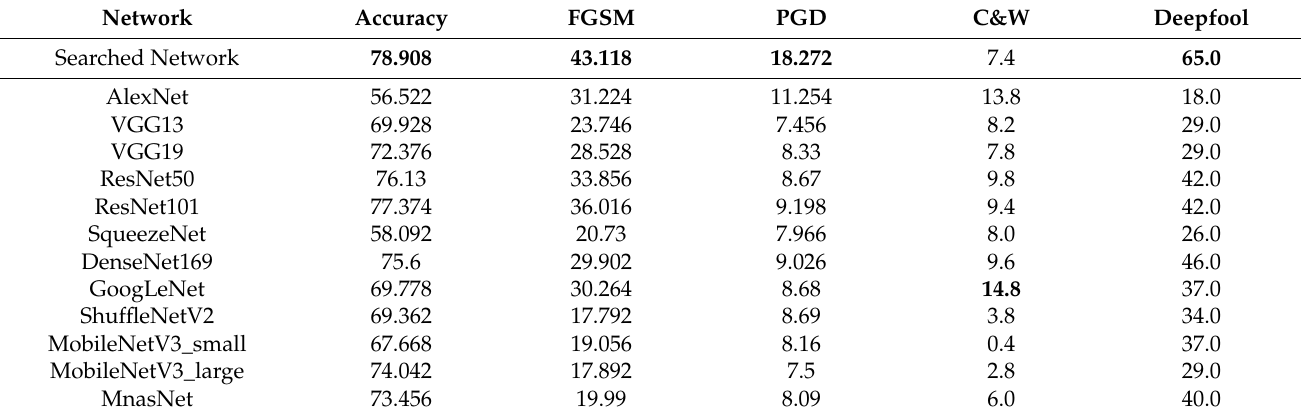
Table 2. Comparison of the network searched by REASON and artificially designed